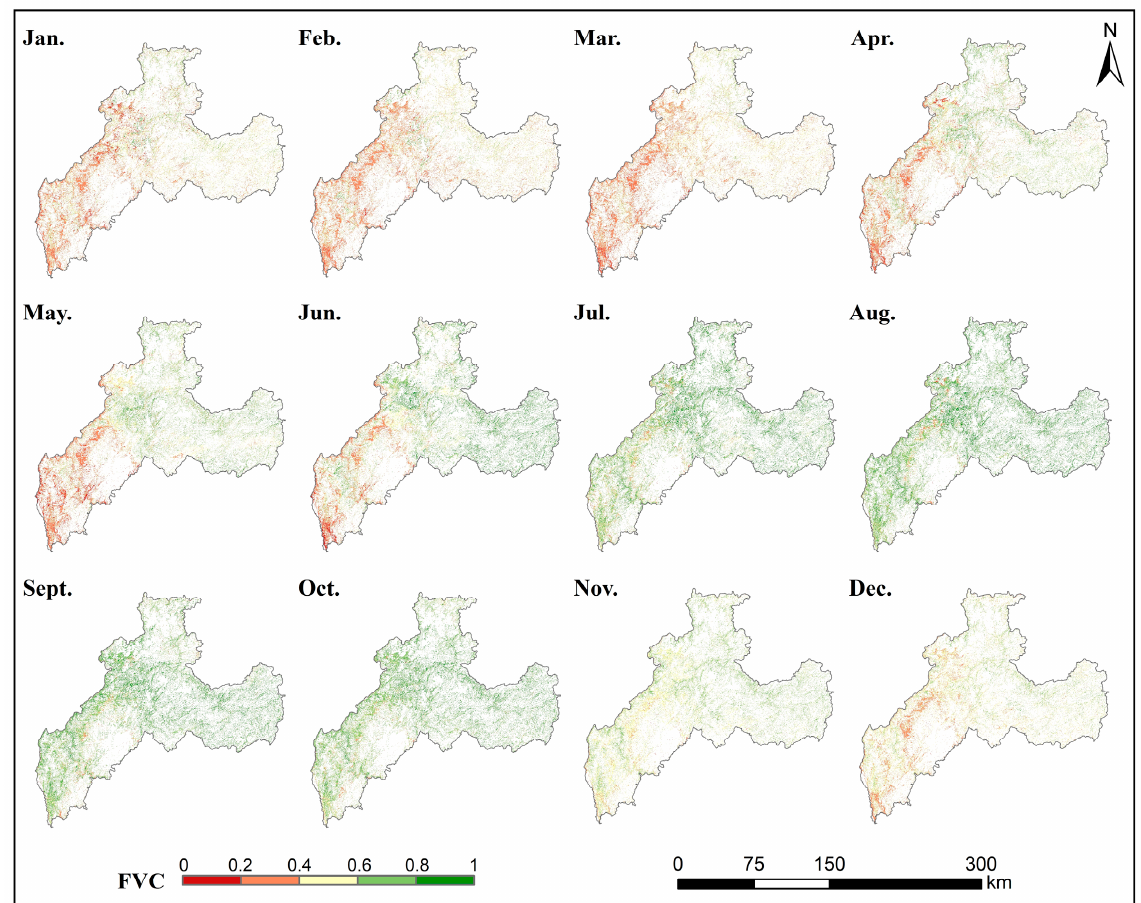
Figure 4. Monthly fractional vegetation coverage (10 m) of grassland in Zhaotong in 2020.